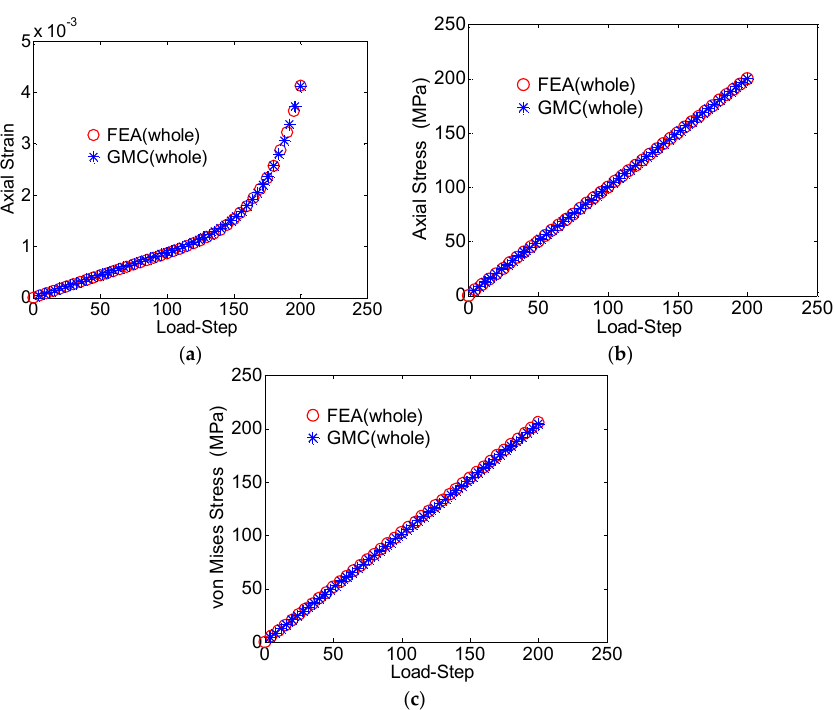
Figure 4. ( a ) Average axial strain ( ε zz ) vs . load-step; ( b ) average axial stress ( σ zz ) vs. load-step; ( c ) von Mises stress vs . load-step, for the entire domain in the two-grain polycrystal model. Materials 2016 , 9 , 335